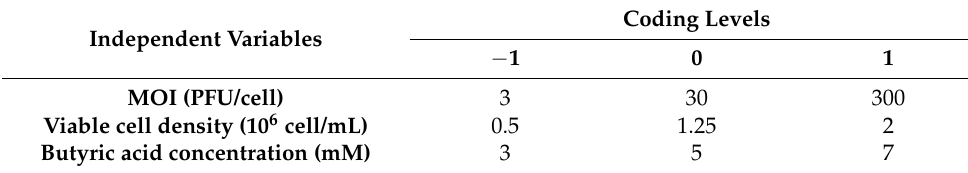
Table 1. Conditions of the independent variables studied in the D-optimal